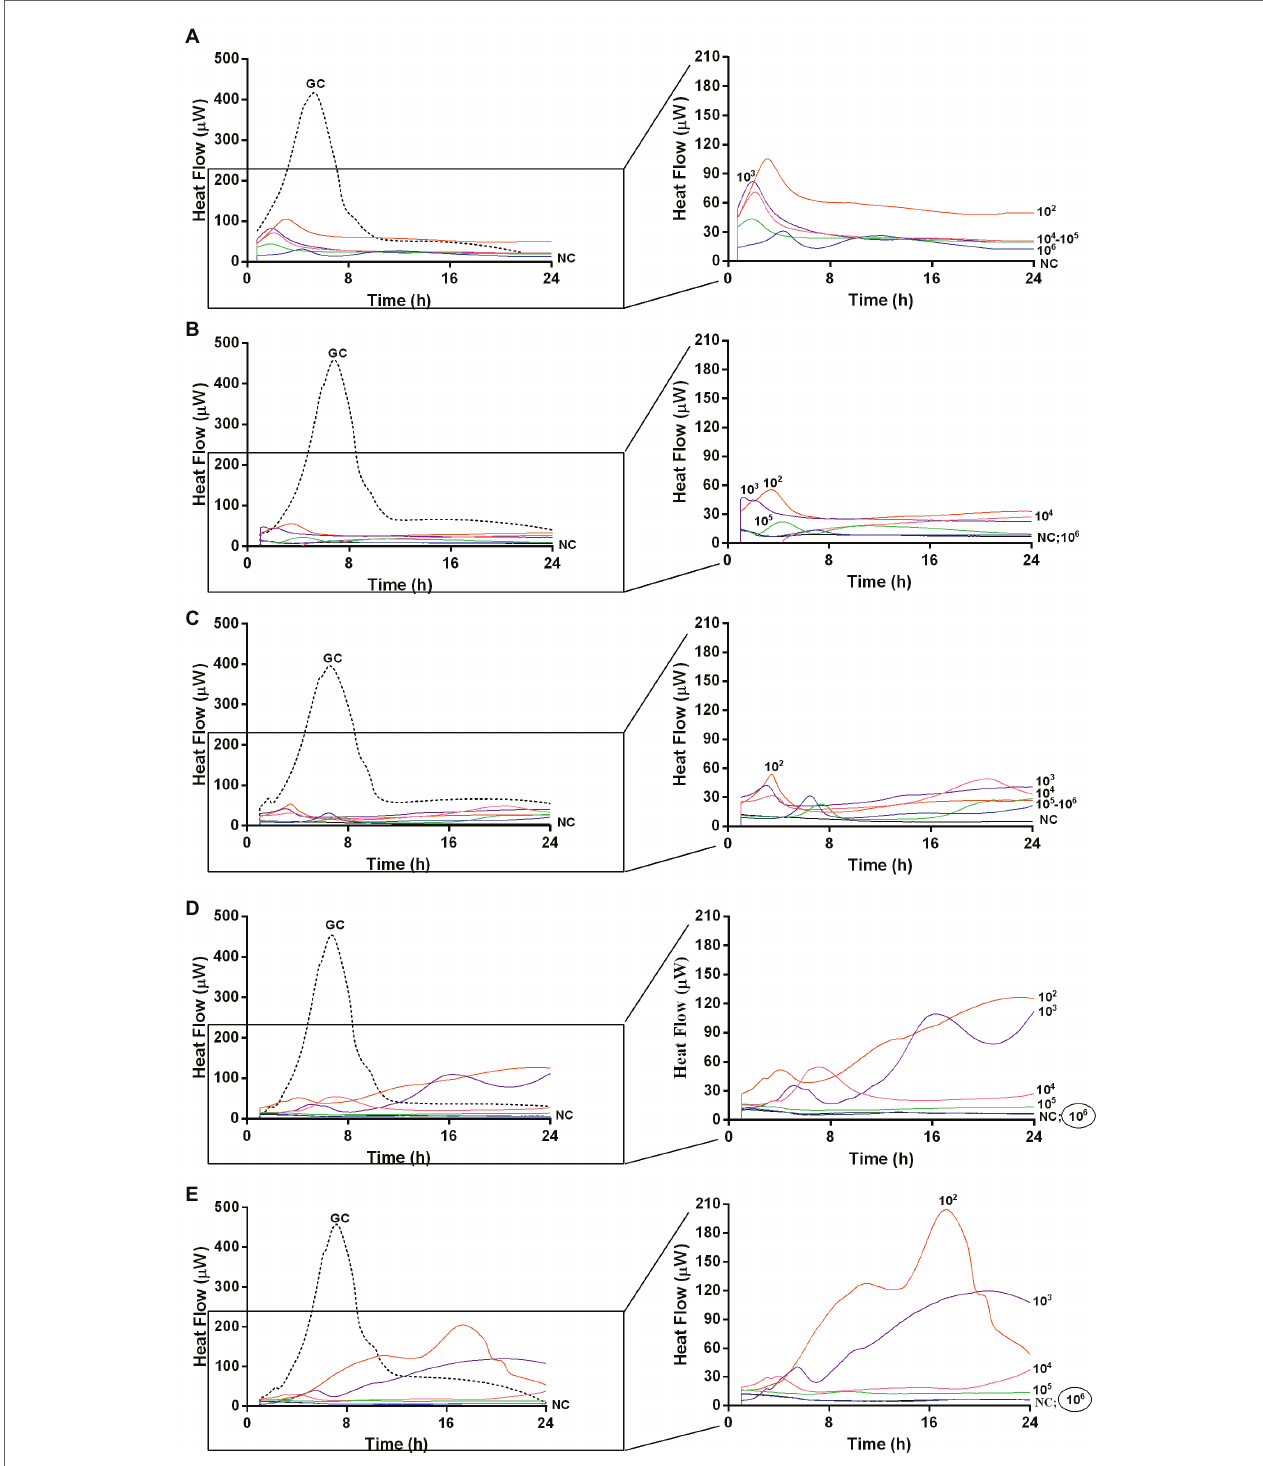
FIGURE 6 | Evaluation of MRSA ATCC43300 biofilm susceptibility to PYO at different time exposures by IMC. Each curve shows the heat produced by viable bacteria present in the biofilm after 24 h (A) , 48 h (B) , 72 h (C) , 120 h (D) , 168 h (E) treatment with different phage titers (ranging from 10 2 to 10 7 PFU/ml). Graphs on the right represent the magnification of the graphs on the left. Numbers above curves represent PYO titers (in PFU/ml). Circled values represent the MBECP. GC, growth control (dashed line); NC, negative